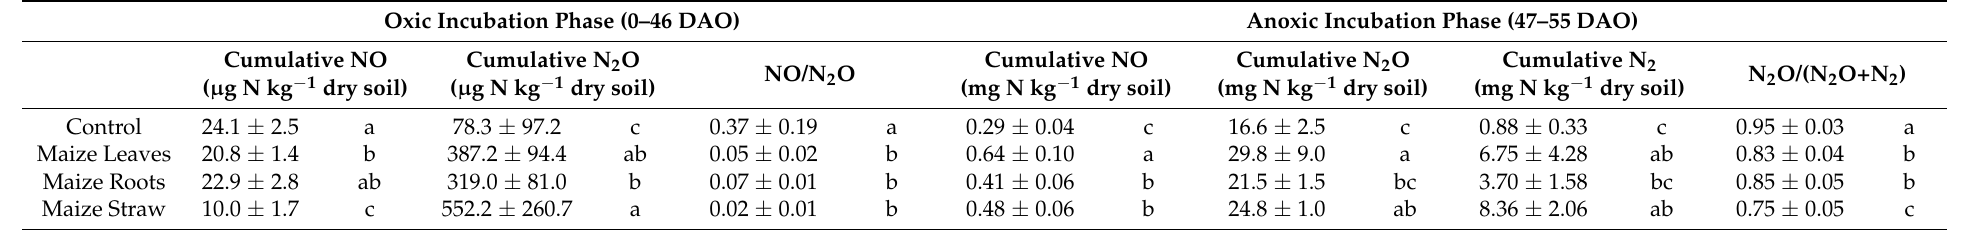
Table 5. Cumulative NO, N 2 O, and N 2 emissions and ratios of gaseous products during oxic and anoxic